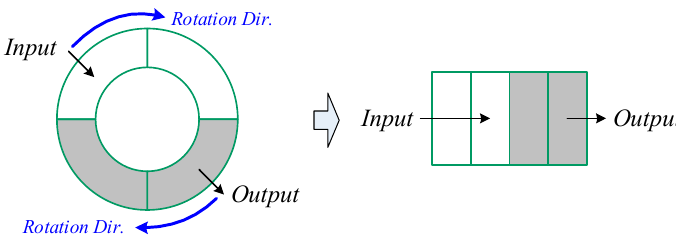
Figure 3. Ring bu ff er operated in a FIFO fashion. Figure 3. Ring buffer operated in a FIFO fashion. Figure 3. Ring buffer operated in a FIFO fashion.